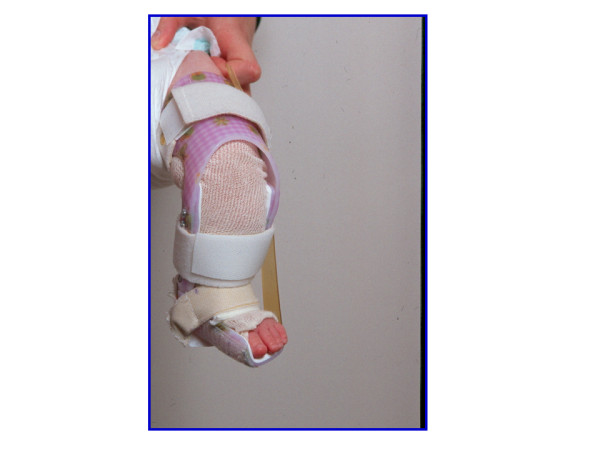
Dynamic Knee Ankle Foot Orthosis (with permission from Scandinavian Orthopaedic technical Laboratory).